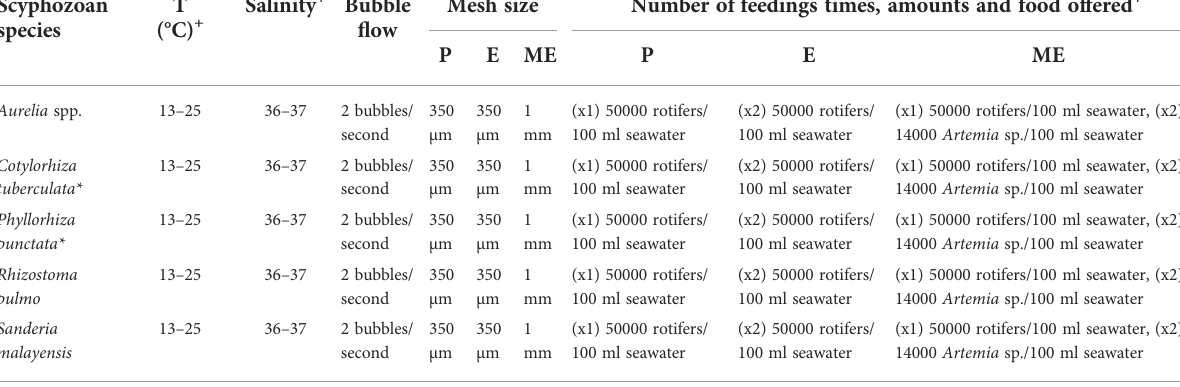
TABLE 1 Culture conditions for polyps, ephyrae and metaephyrae of some metagenetic species in fl ow-through system. Scyphozoan T Salinity + Bubble Mesh size Number of feedings times, amounts and food offered fl ow species (°C) +